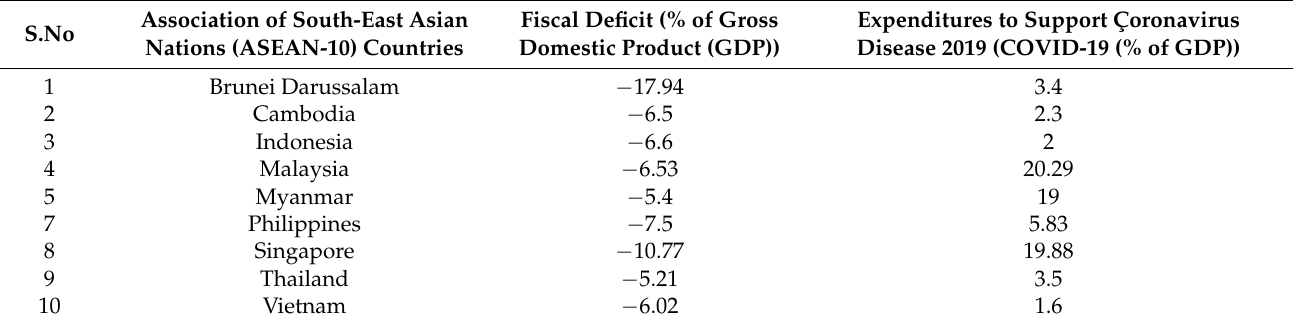
Figure 1. Fiscal balance difference between October 2019 and April 2020 projections for the Associa- tion of South-East Asian Nations (ASEAN-10) (%GDP), Source: ESCAP (based on World Economic Outlook databases.). Table 1. Health expenditure and fiscal deficit in ASEAN,